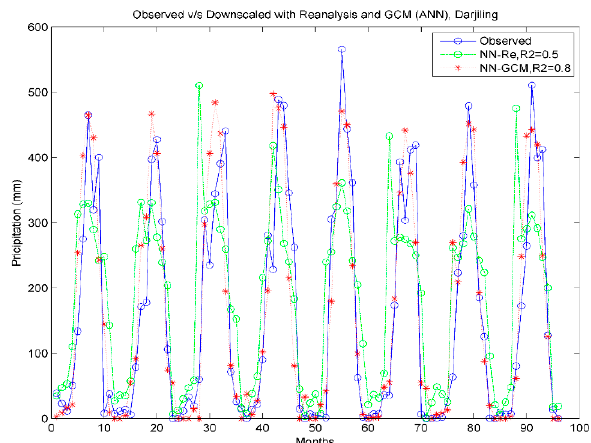
Figure 7. Modeled v / s observed zonal averaged precipitation with Re-Obs and the GCM-Obs models for Darjeeling. GFDL-CM3 GCM is used for the GCM-Obs model. Notations are the same as shown in Figure 6.